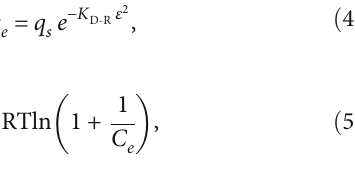
Table 2: Isotherm data for Cd(II) adsorption by Fe nanocomposite (time: 210min; C o : 25-300mg/L; adsorbent dose: 0.01g; agitation speed: